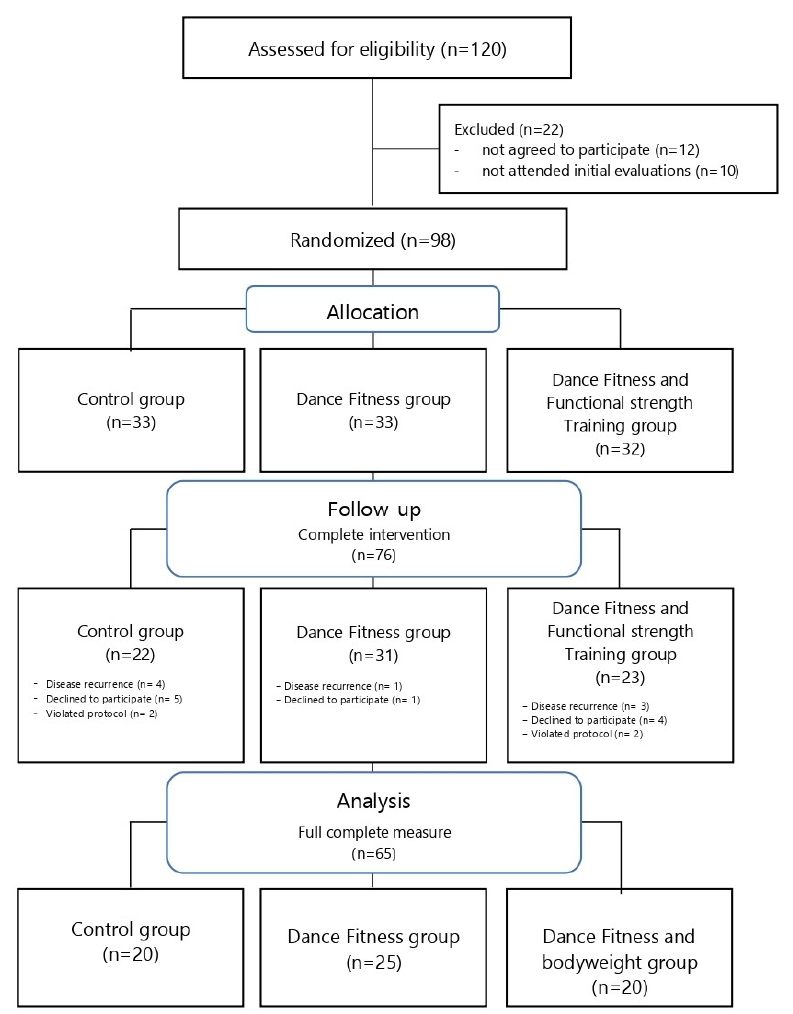
Figure 1. Flow diagram of the